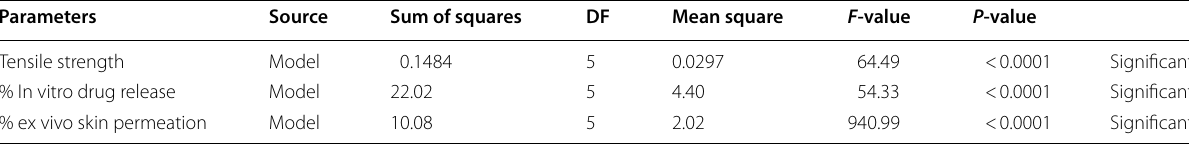
Table 7 ANOVA for tensile strength, % in vitro drug release, and % ex vivo skin permeation (F1–F9) Parameters